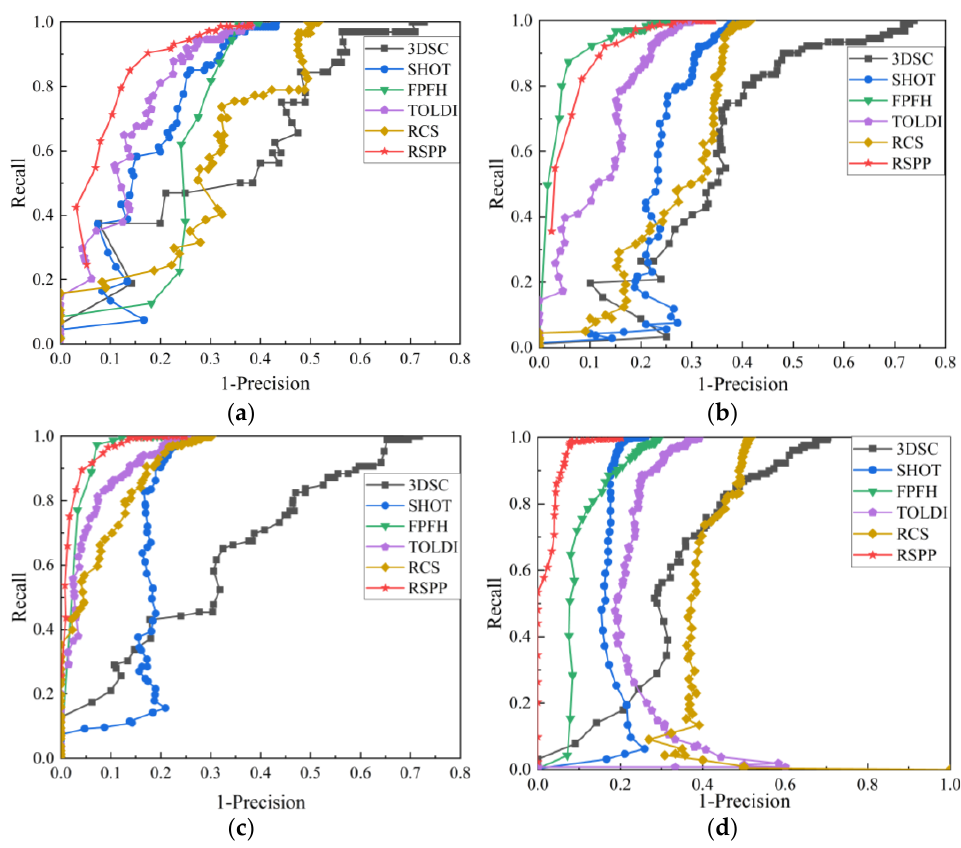
Figure 8. RP curves of different feature descriptors under noise-free conditions: ( a ) RP curve of Bunny dataset; ( b ) RP curve of Buddha dataset; ( c ) RP curve of Dragon dataset; ( d ) RP curve of Armadillo dataset.